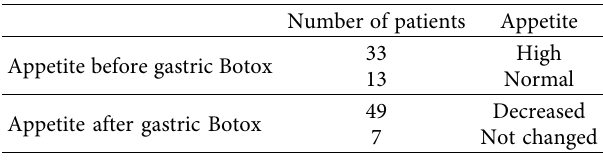
Table 3: Effect of gastric Botox on appetite of patients.